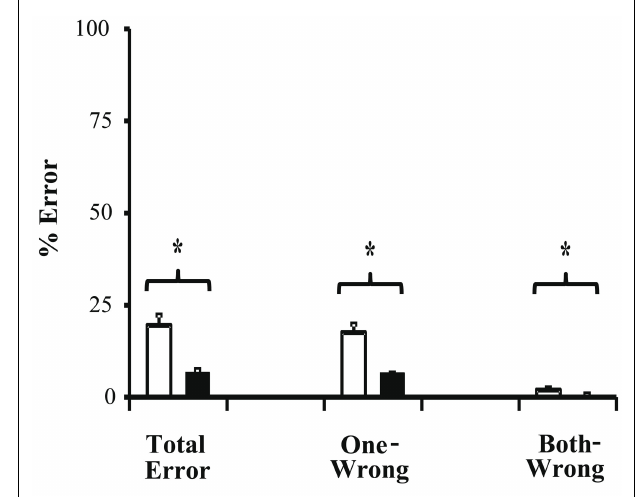
FIGURE 5 | Error rates for Experiment 1. There was a significant decrease in total error rate ( W s = 26.00, z =− 2.90, p = 0.002) in the color-segmented condition (black bars; 6.67 ± 0.75%) compared to the unicolor condition (white bars) 19.52 ± 2.74%). One-wrong errors accounted for the majority of the total error rate and had a corresponding significant decrease ( W s = 26.00, z =− 2.90, p = 0.002) in the color-segmented condition (6.51 ± 0.75%) compared to the unicolor condition (17.55 ± 2.26%).The both-wrong rate, while showing a significant difference ( W s = 31.00, z =− 2.45, p = 0.013) between the color-segmented (0.17 ± 0.06%) and unicolor (1.97 ± 0.57%), accounted for only a very small portion of the total error trials. Errors bars are